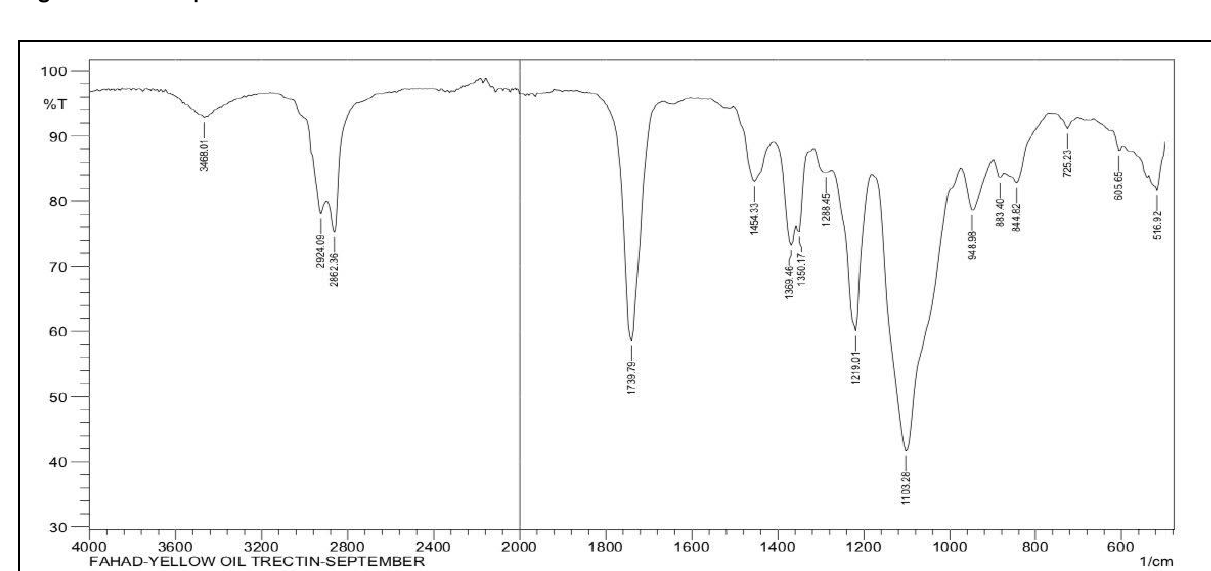
Figure 4. FTIR spectrum of selected PIR SNEDDS F4 formula